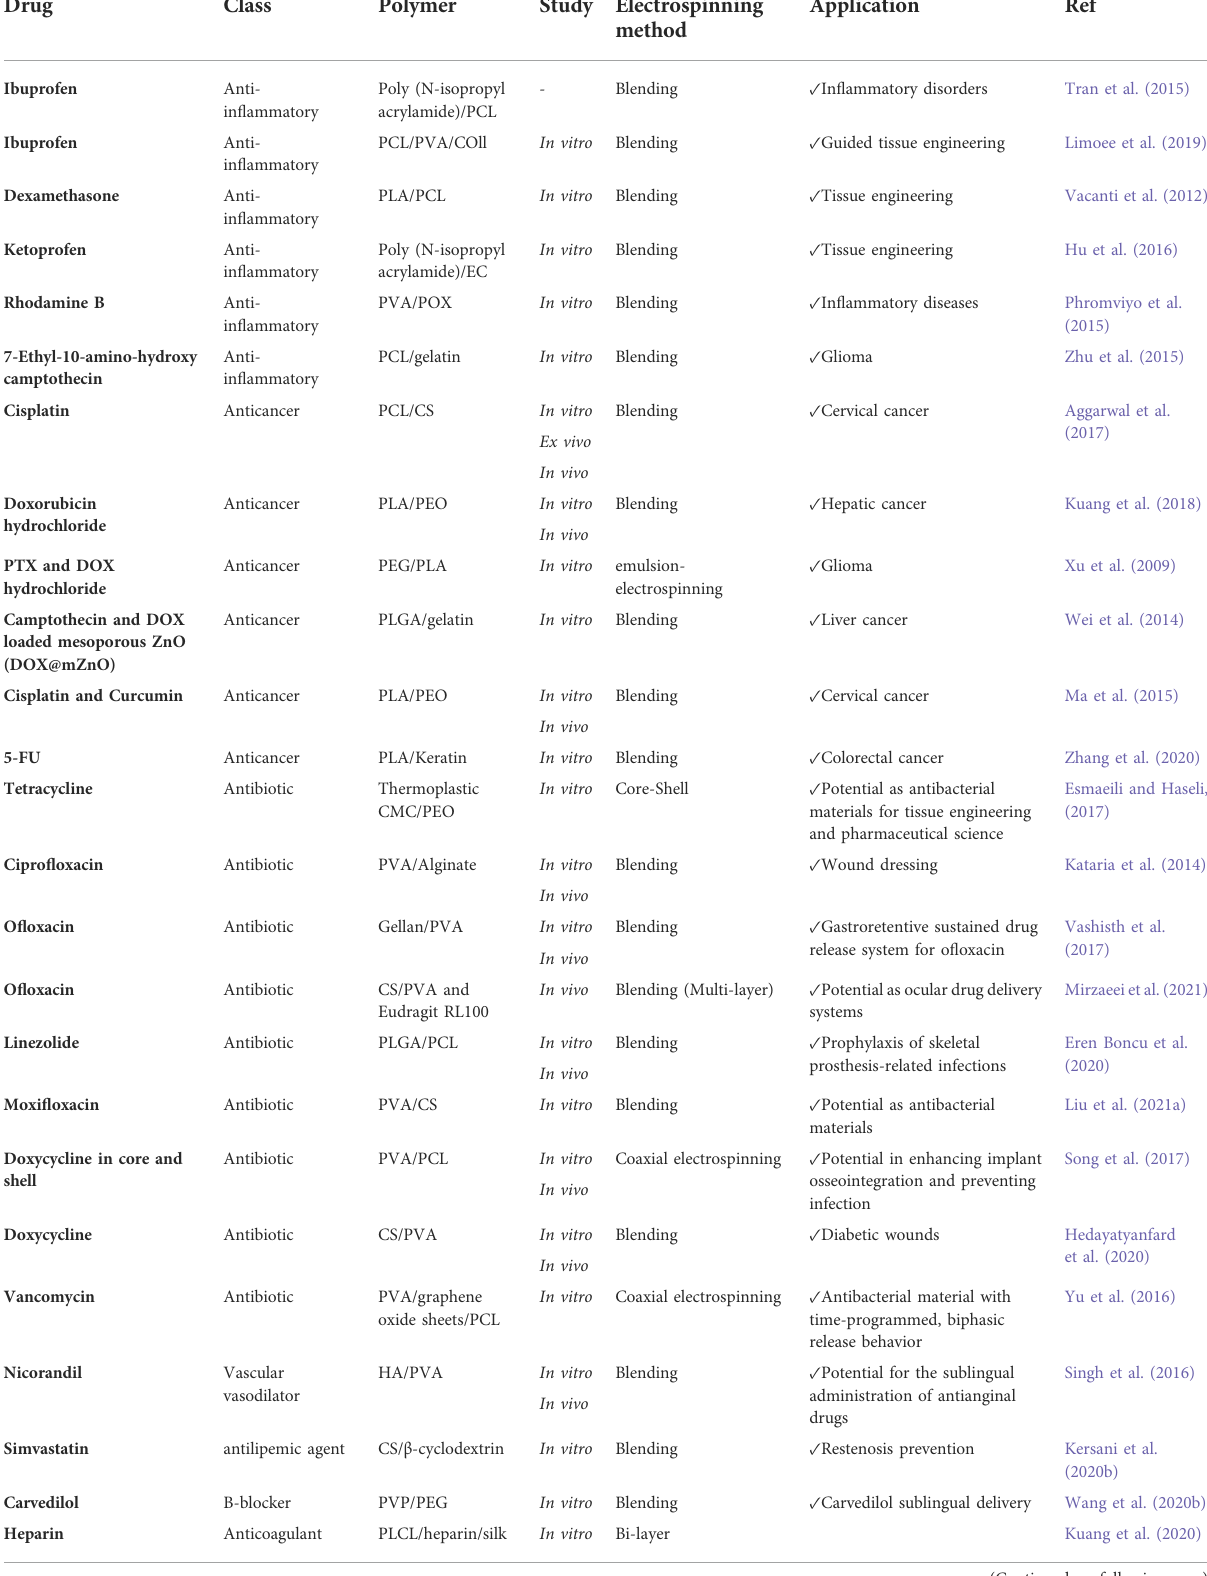
TABLE 3 An overview of electrospun hybrid nano fi ber for drug